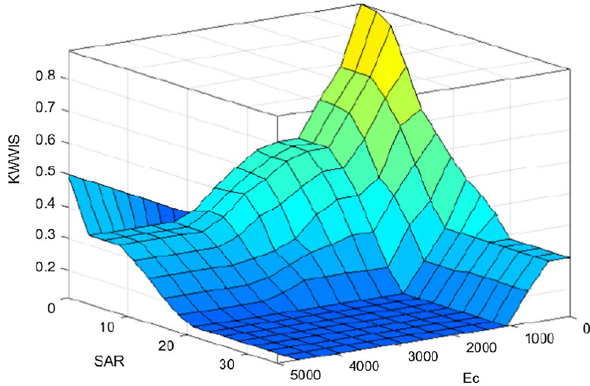
Fig. 3 Fuzzy surface: Ec and SAR versus